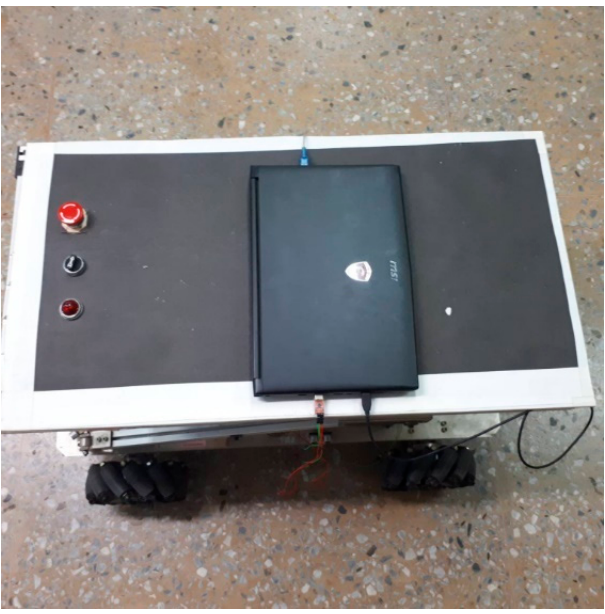
Figure 4. The appearance of the omnidirectional Mecanum-wheeled automated guided vehicle.